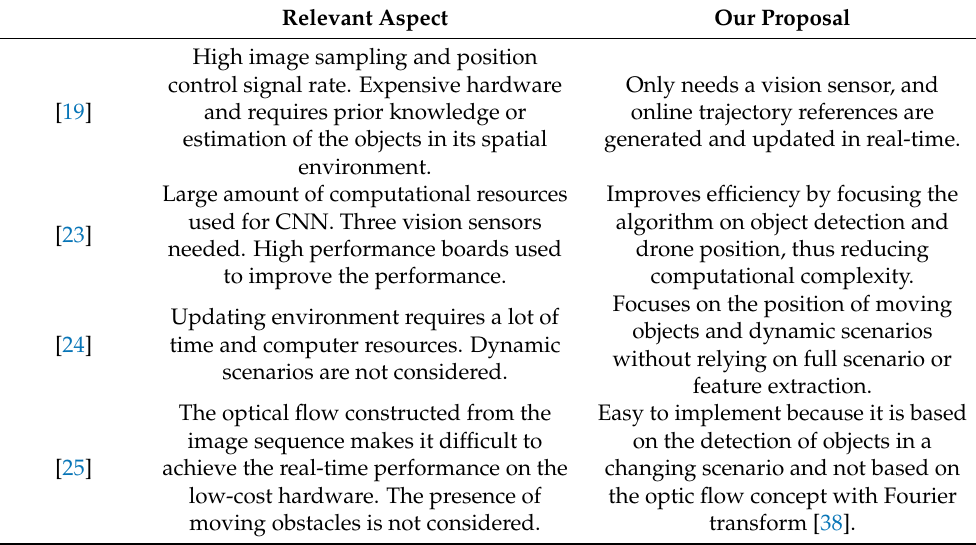
Table 6. Comparison between related work and TGBOA